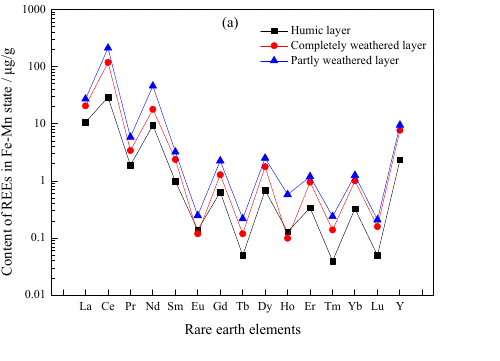
Figure 6. The rare earth content and proportion of iron–manganese oxide. ( a ) Content of Fe–Mn oxide state rare earth elements in each weathered layer; ( b ) The proportion of rare earth elements in the Fe–Mn oxide state of rare earth ore in each weathered layer.